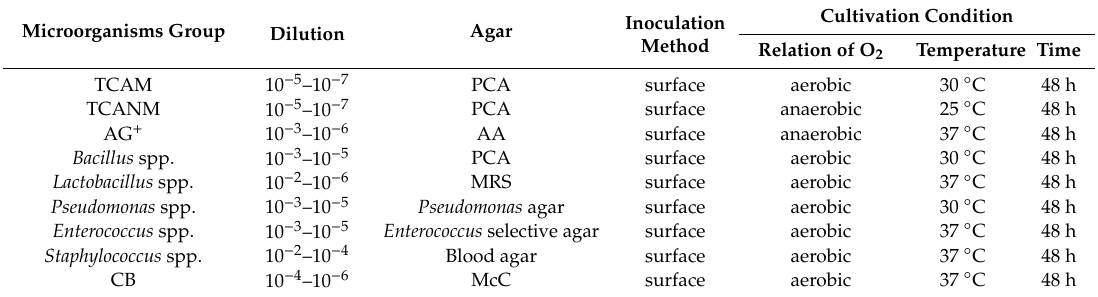
Table 7. Incubation conditions of bacteriota of the intestine of honey bees. Microorganisms